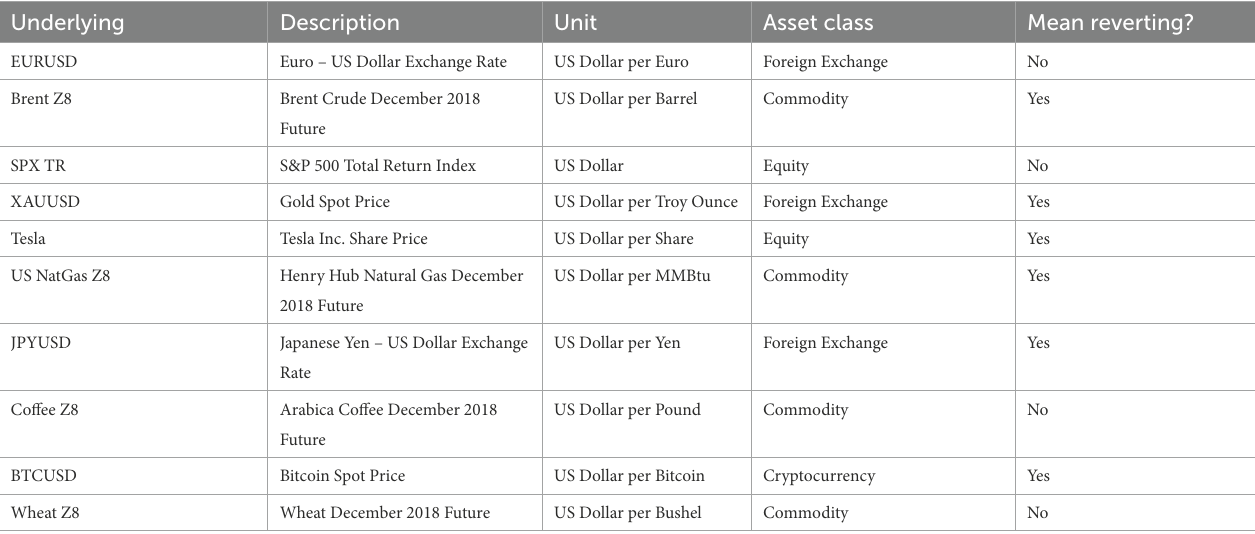
TABLE 1 Securities depicted in choice sets.